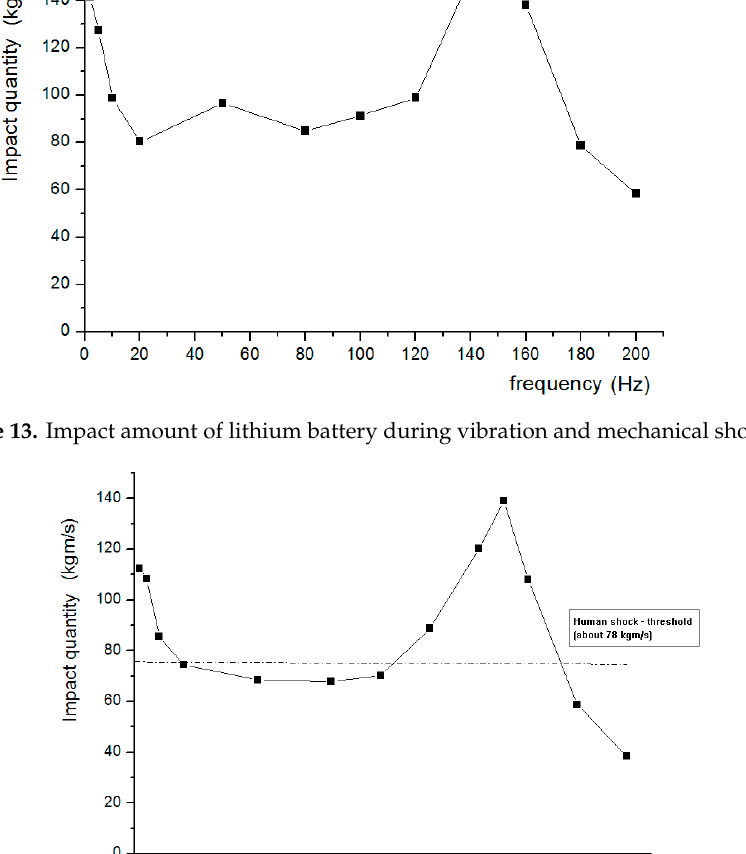
Figure 14. The amount of impact received by the human body during the vibration and mechanical shock test.